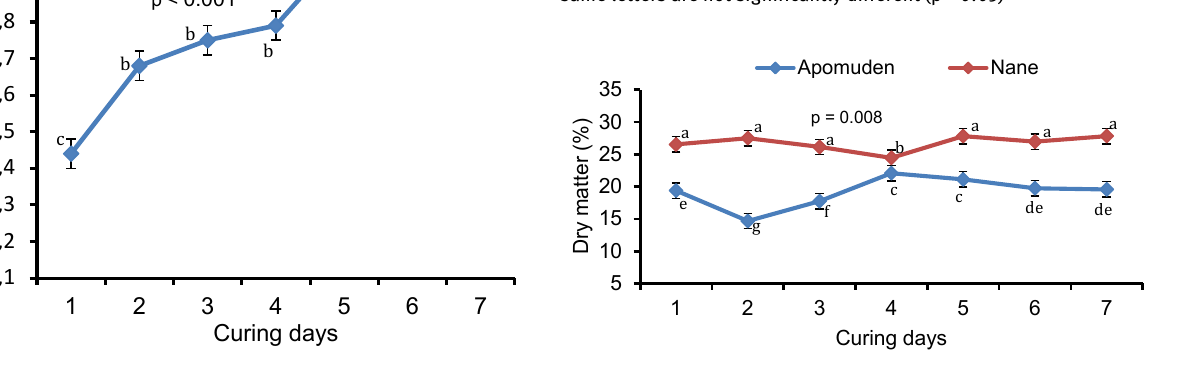
Figure 5: Dry matter content of sweetpotato cultivars. Bar values (least square means ± SEM, n = 3). Least square means with the same letters are not significantly different (p > 0.05)